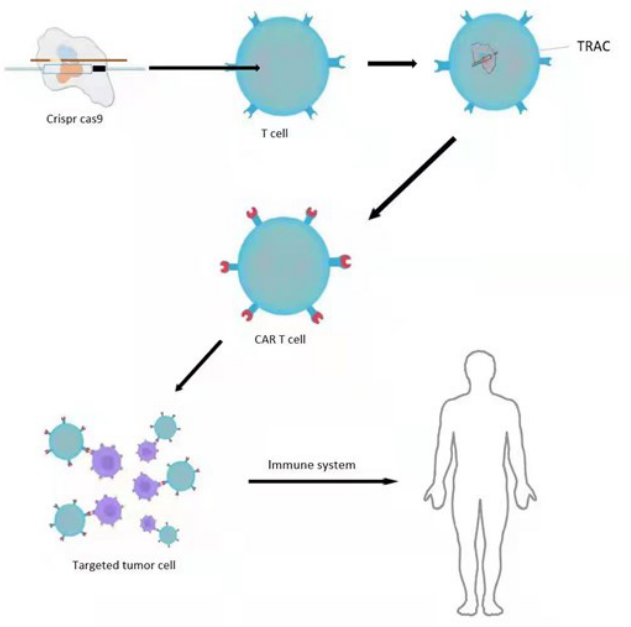
Figure 3. Production of CAR-T Cells. CRISPR/CAS9 was applied in the CD19-specific CAR targeted T-cell receptor α constant (TRAC) loci to result in the uniform CAR expression in human peripheral blood T lymphocytes, and later, the CAR-T cells selectively attacked tumor cells to achieve the treatment effect.